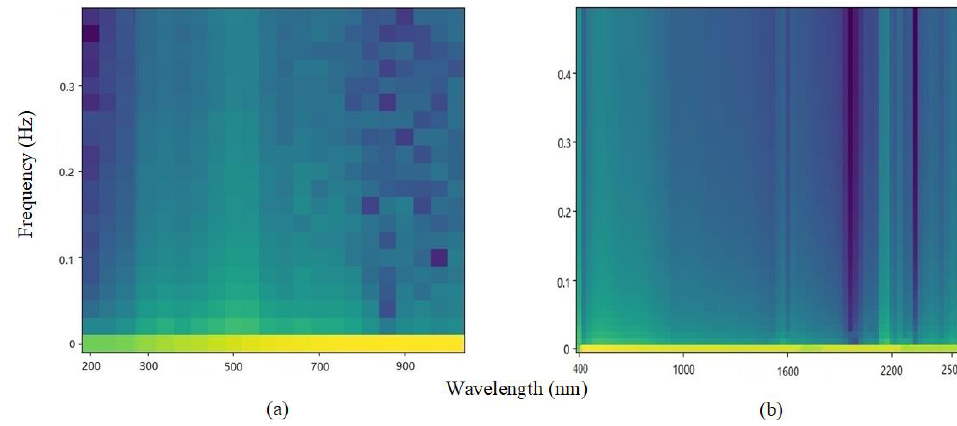
Figure 3. Spectrograms of samples of ( a ) Small dataset ( b ) LUCAS dataset. (The yellower the color represents the greater the spectral frequency density at this wavelength, the bluer the color, the lower the density.)